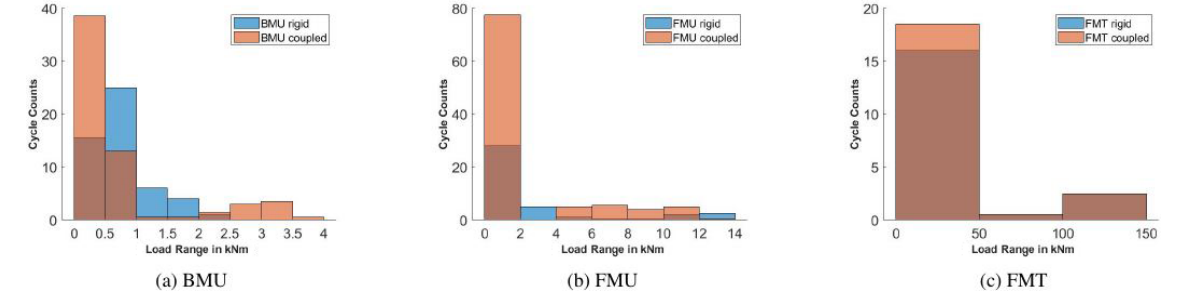
Figure 21. Comparison of number of cycle counts to load ranges using M x from CFD as input.